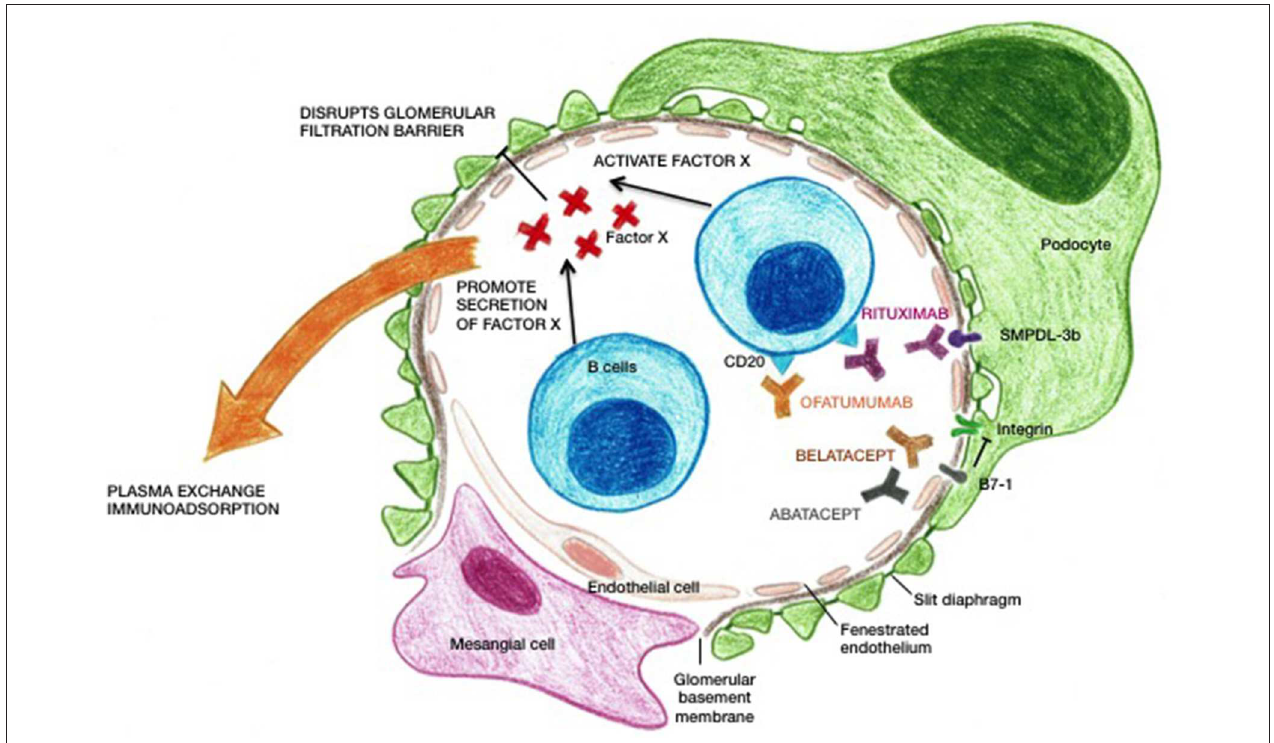
FIGURE 2 | Scheme illustrating the therapeutic targets in recurrent FSGS. Factor X denominates the yet unidentified circulating permeability factor(s).